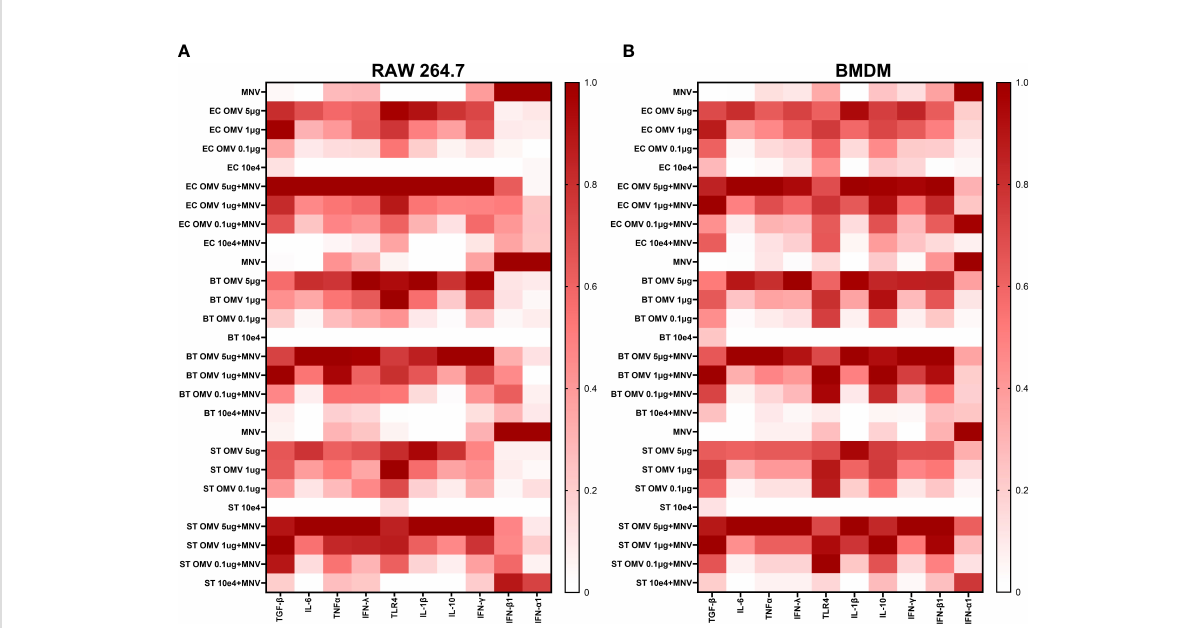
FIGURE 5 OMVs alter expression of antiviral and in fl ammatory cytokine genes during MNV infection of macrophages. RAW264.7 cells and BMDMs were treated with inactivated bacteria, OMVs only, MNV only, MNV+OMV, inactivated bacteria+MNV, or mock virus. Cells were harvested at 18 hours post infection and the RNA transcripts measured using the QuantiGene assay. Output data was normalized with HPRT1 mRNA readings for each sample and then normalized to the mock virus readings for each cytokine mRNA transcript. Heatmaps summarizing the change in transcript expression relative to mock for TGF- b , IL-6, TNF a , IFN- L , TLR4, IL-1 b , IL-10, IFN- g , IFN- b 1, IFN- a 1 transcripts. (A) RAW264.7 and (B) BMDMs. MNV-only infections were performed and analyzed separately for each bacterial OMV treatment.